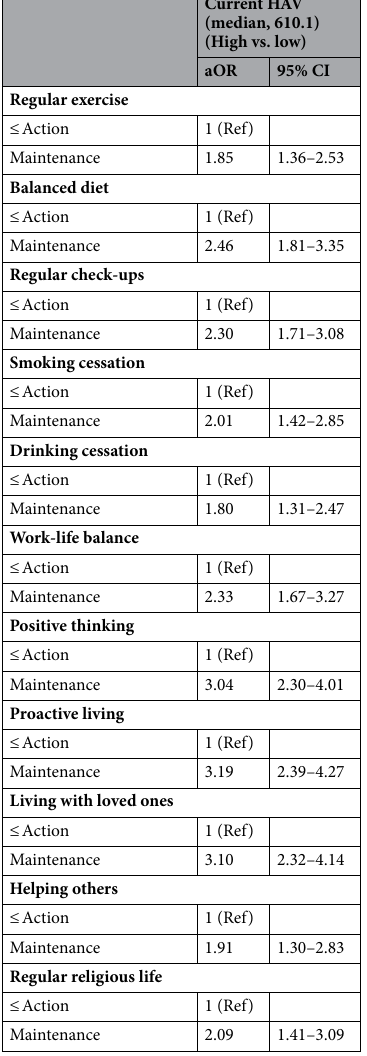
Table 5. Associations of current health asset value with maintenance of health behaviors for more than 6 months, for age, sex, income, and comorbidity ( n = 1000), multiple stepwise model*. HAV health asset value, aOR adjusted odds ratios, Ref reference. † Multiple stepwise logistic regression models selected significant variables with p-value of stay = 0.05, leave = 0.05, adjusted with age (≤ 50 vs. > 50), sex (male vs. female), household monthly income (< 3000$ vs. 3000$ ≤), and comorbidity (no vs.